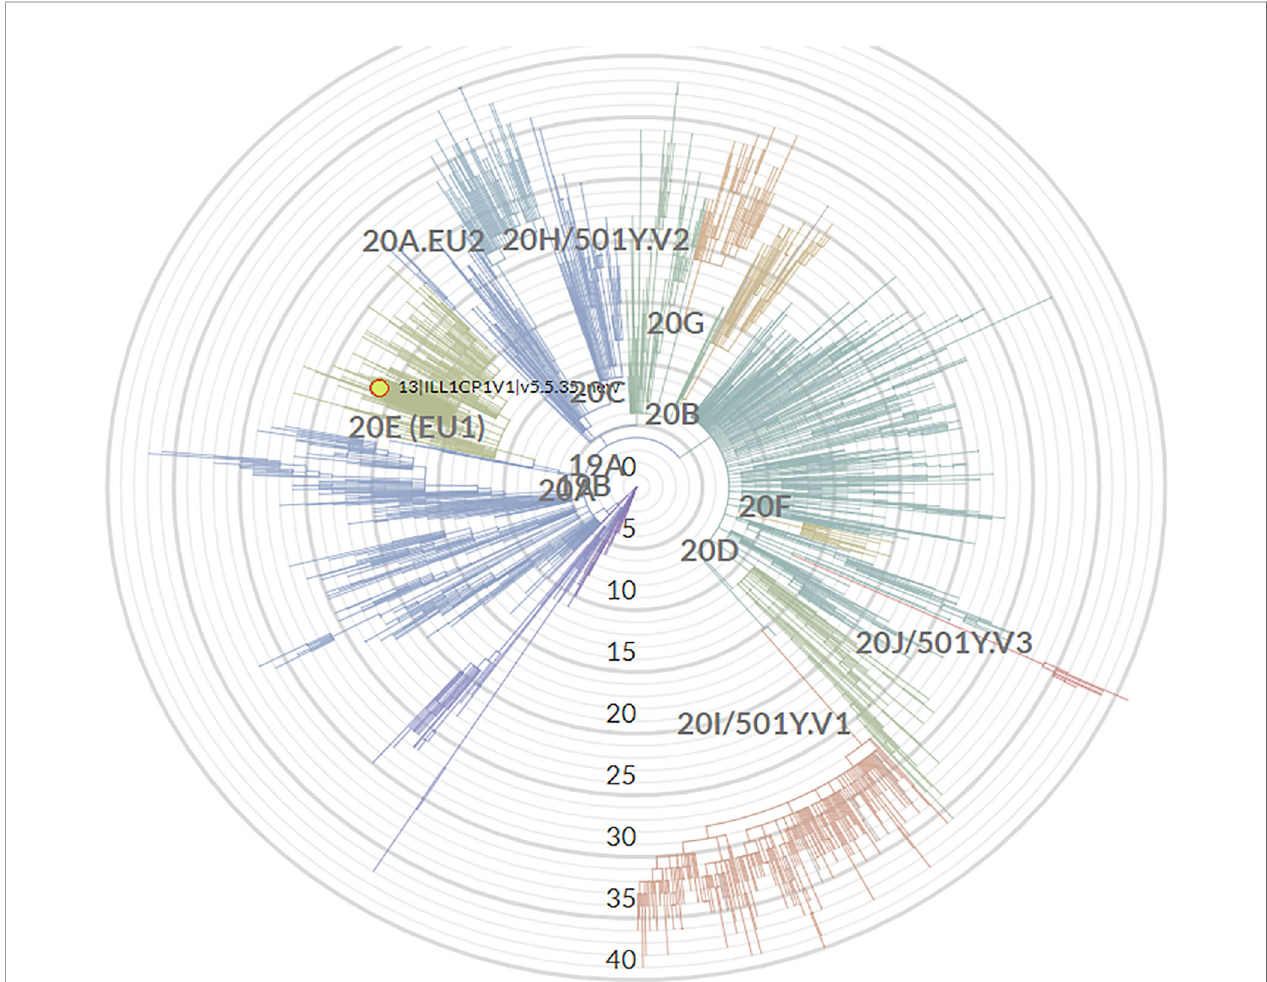
FIGURE 2 | Phylogeny of SARS-CoV-2 clade obtained in our female